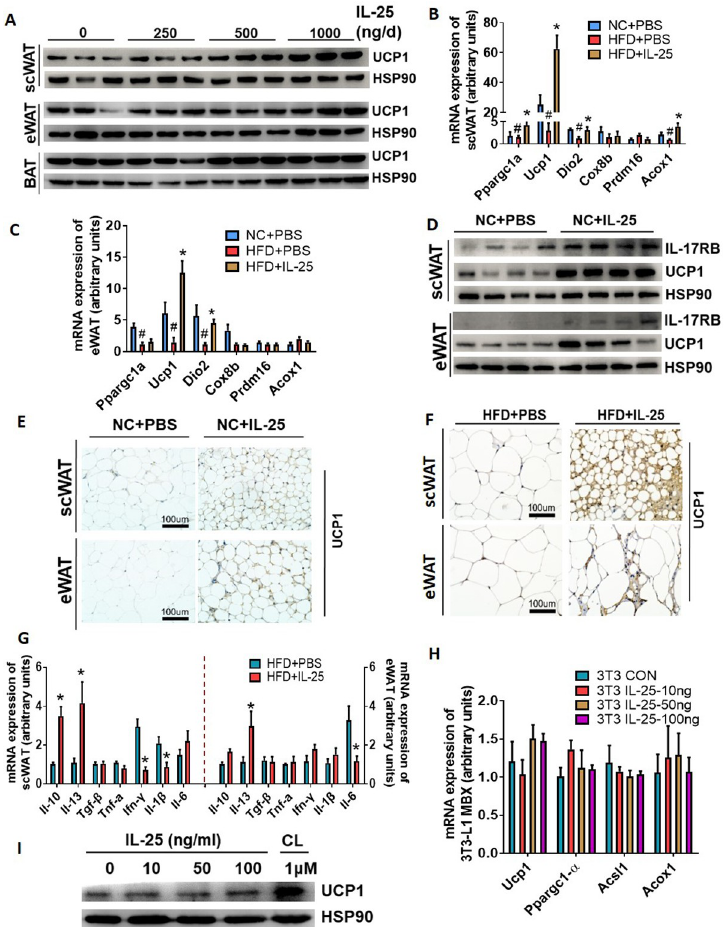
Fig 2. IL-25 induced the browning of WAT and affected inflammatory cytokines in vivo independent of a direct action on adipocytes. (A) Immunoblot was used to quantify the expression of UCP1 (3 representative bands are shown) in adipose tissues of WT mice administrated with various doses of IL-25 for 7 days ( n = 5) (The auto exposure time of eWAT was significantly longer than scWAT). (B–G) WT mice fed with NCD or HFD for 12 weeks were injected with IL-25 (1 μ g/day) over 7 days. (B, C) qPCR analysis of markers associated with β -oxidation and thermogenesis in scWAT (B) and eWAT (C). (D) Immunoblot analysis of IL-17RB and UCP1 protein in WAT. (E, F) Representative images of WAT stained for UCP1 from mice fed with NCD (E) or with HFD (F). 200 × magnification (top), 400 × magnification (bottom). (G) C57/BL6J mice ( n = 5) fed with an HFD for 12 weeks were administrated with vehicle or IL-25 (1 μ g/day) over 14 days and then qPCR analysis of genes associated with pro/anti-inflammatory cytokines in scWAT and eWAT. (H, I) Differentiated 3T3-L1 MBX cells (adipocytes) were treated with various doses of IL-25 or CL. (H) The mRNA expression of thermogenesis or β -oxidation genes. (I) Immunoblot analysis of UCP1 protein in adipocyte. The data underlying this figure can be found in S1 Data. BAT, brown adipose tissue; CL, CL-316, 243; eWAT, epididymal WAT; HFD, high-fat diet; IL, interleukin; IL-17RB, IL-17 receptor B; NCD, normal chow diet; qPCR, quantitative PCR; scWAT, subcutaneous WAT; UCP1, uncoupling protein 1; WAT, white adipose tissue; WT,